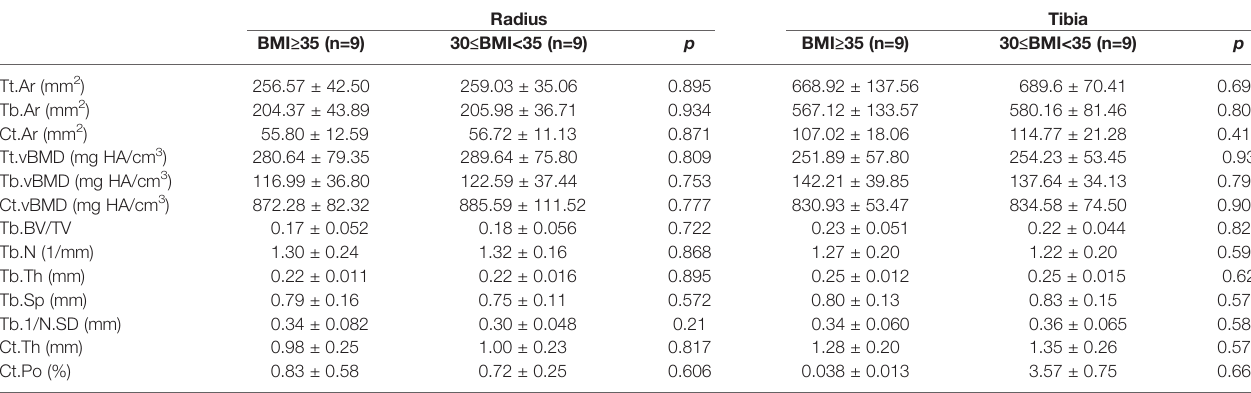
TABLE 4 | Comparisons of bone microarchitecture in severely obese women and age- and height-matched moderately obese